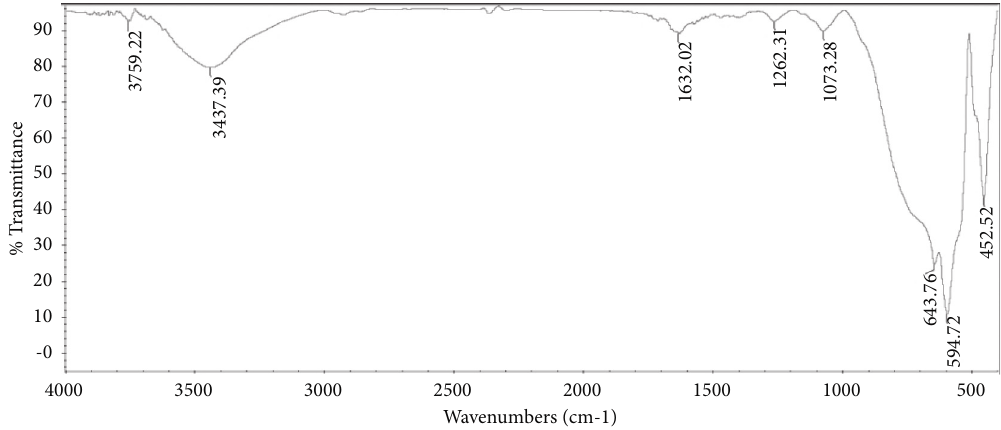
Figure 4: FT-IR spectrum of Al